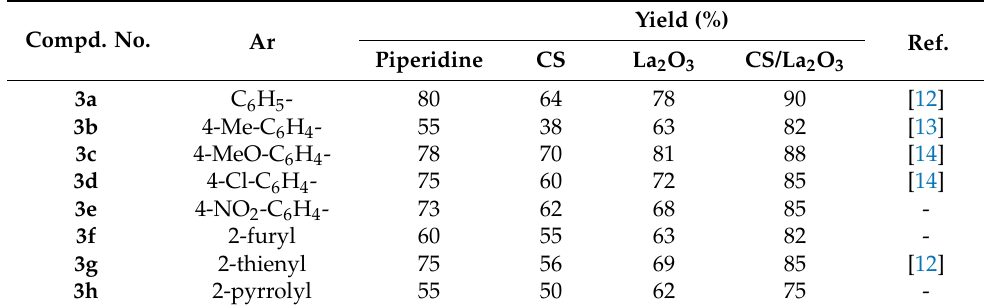
Table 2. Yield percent of products 3a – h.